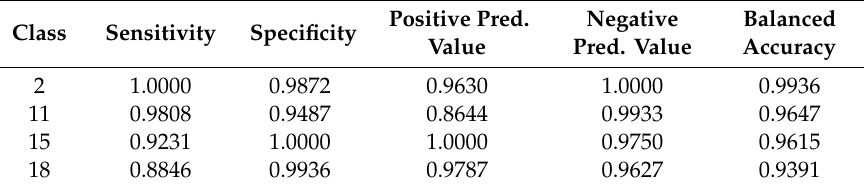
Table 10. Statistics by class for zones 2, 11, 15 and 18.